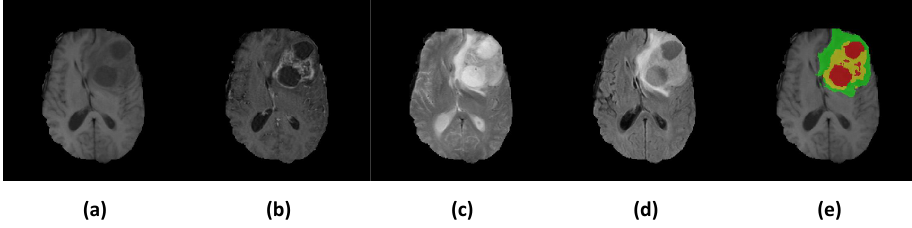
Figure 1. Illustrations of multimodal MR images from the BraTS 2018 dataset [5,7]. ( a ) T1; ( b ) T1ce; ( c ) T2; ( d ) Flair; ( e ) Ground truth, in which red indicates NCR/NET regions, yellow indicates ET regions, and green indicates ED